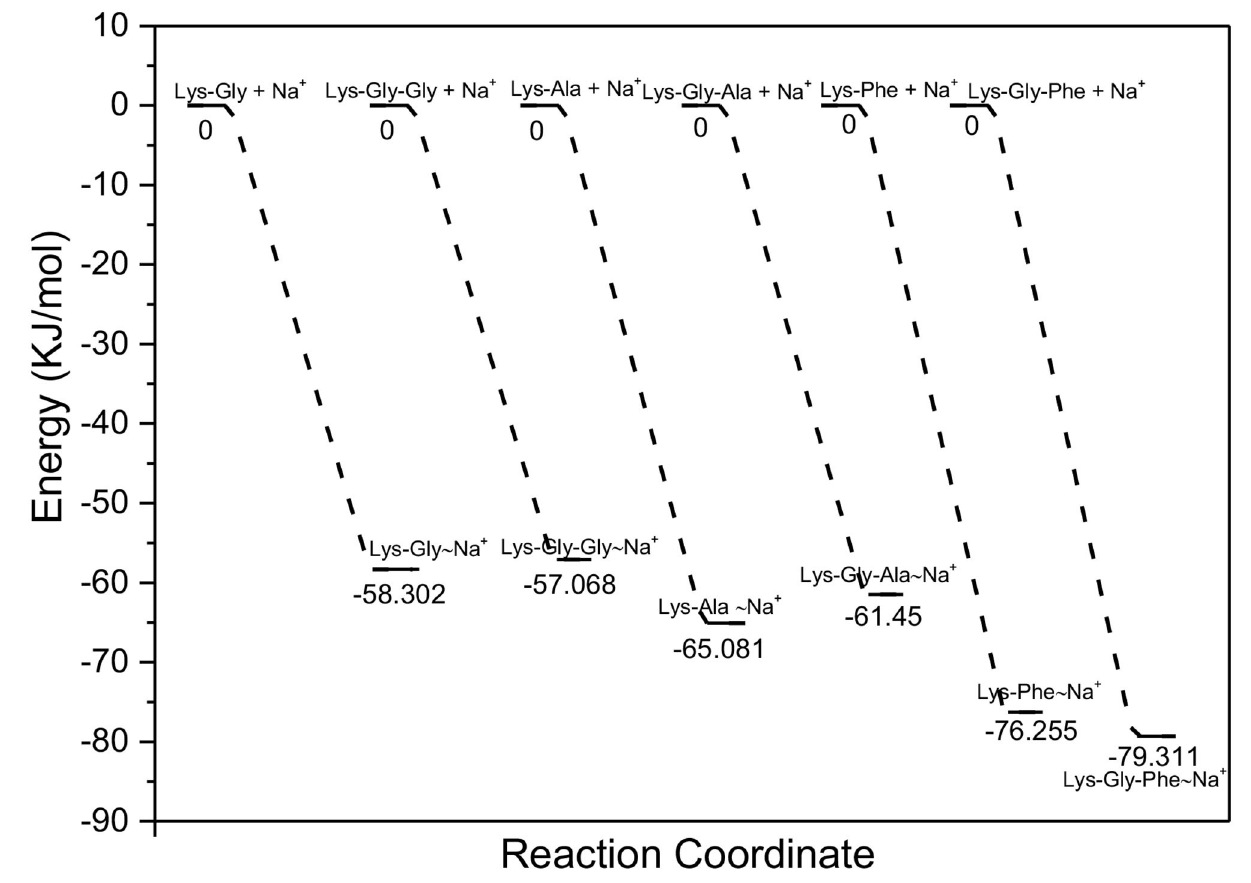
FIGURE 4 | Enthalpy changes for the formation of the proposed peptide-sodium